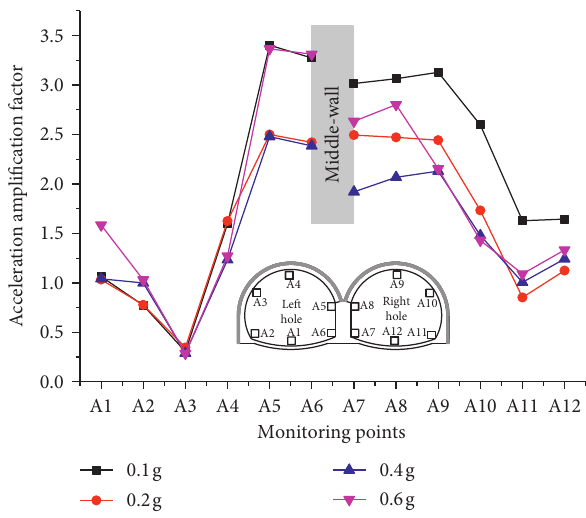
Figure 13: Variation trends of AAF of WC-XZ in the Z -direction.